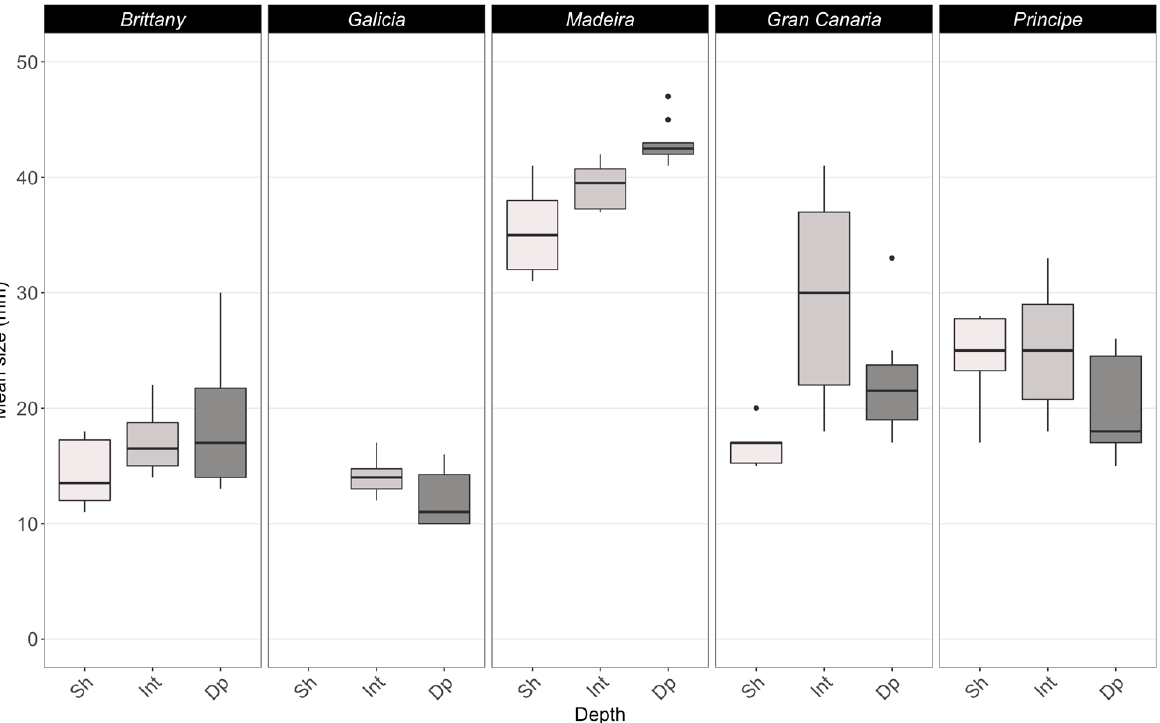
Figure 3. Mean diameter (mm) of rhodoliths at each depth stratum (Sh: Shallow; Int: Intermediate and Dp: Deep) and region. Data pooled for the two locations within each region.